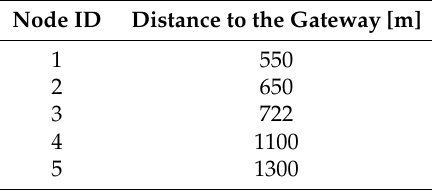
Table 4. Distances from nodes to the